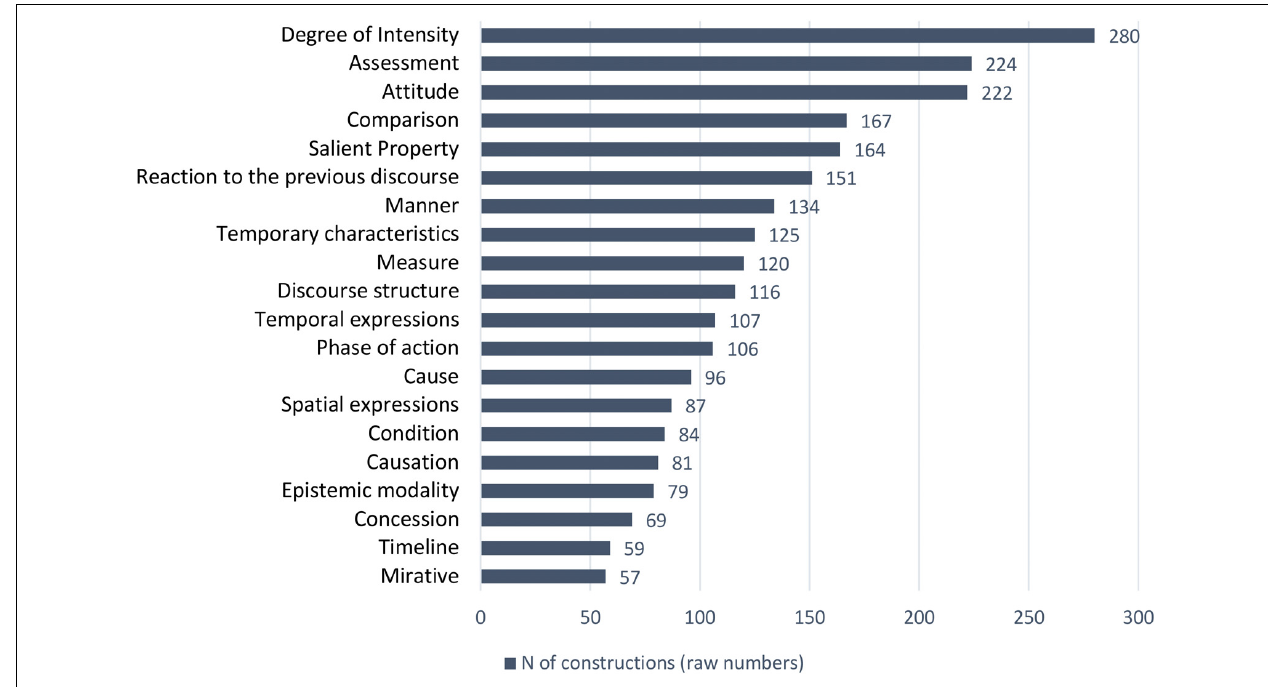
FIGURE 1 | Distribution of constructions across twenty major semantic tags of top